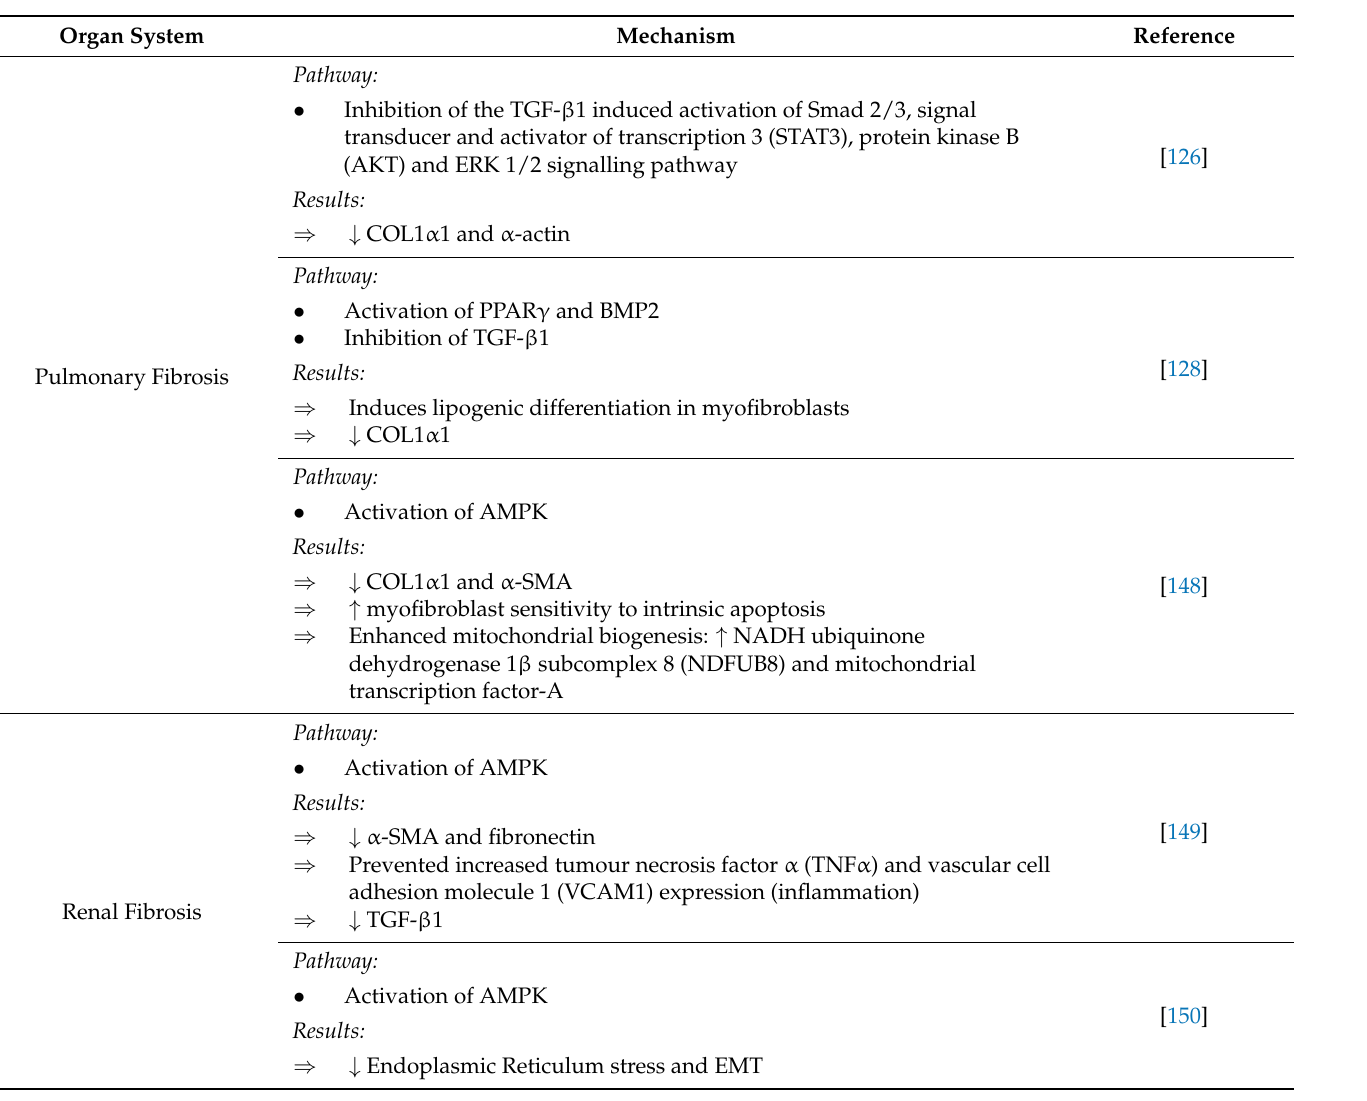
Table 4. Anti-fibrotic effects of metformin in multiple organ